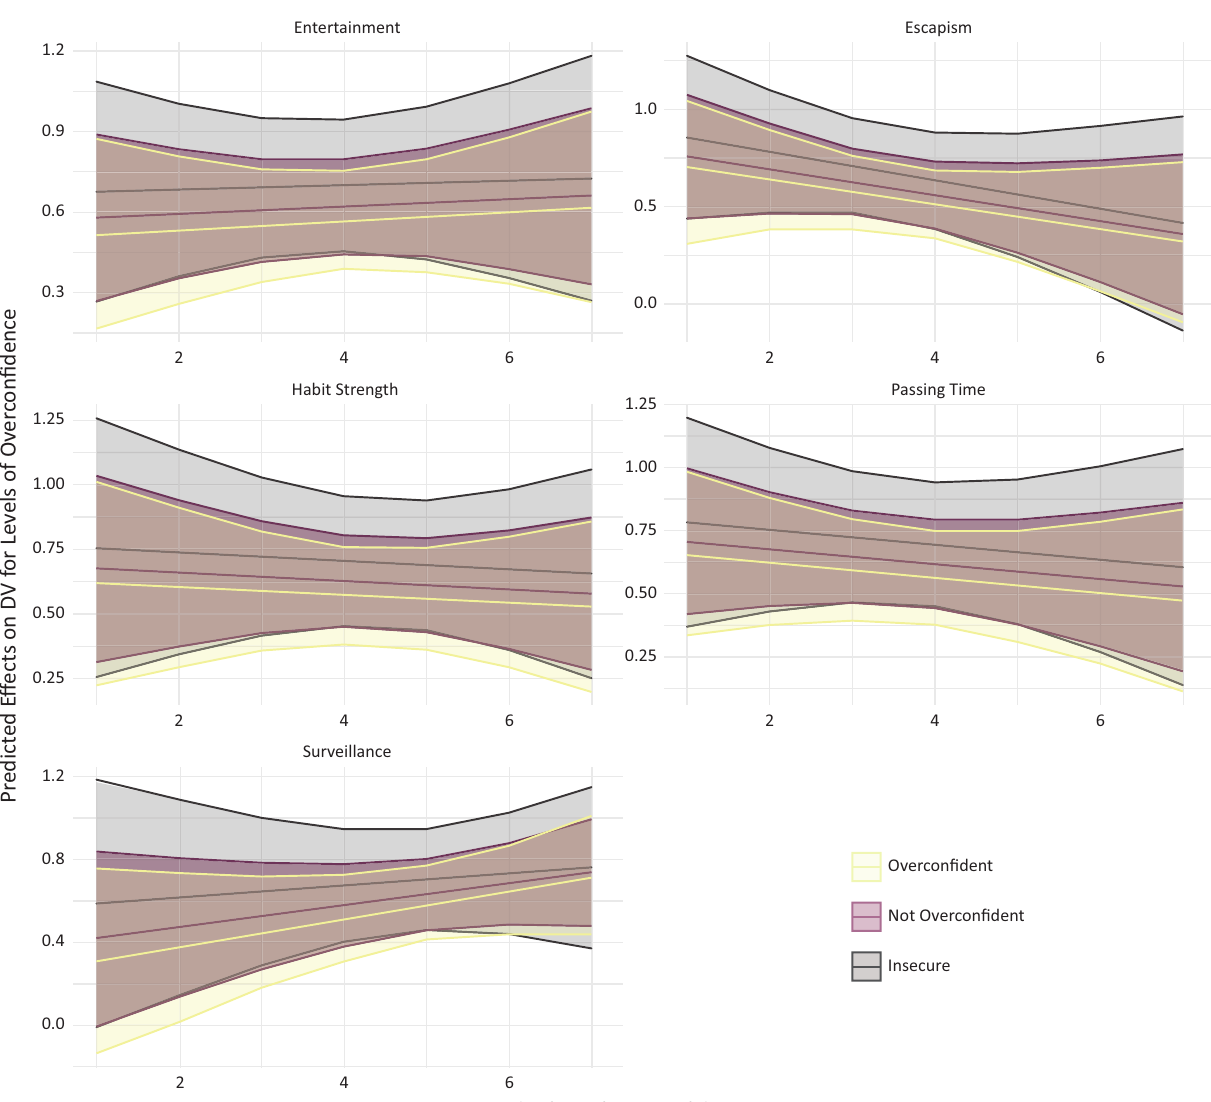
Figure 10. Predicting appreciation for self‐selecting news for different levels of epistemic